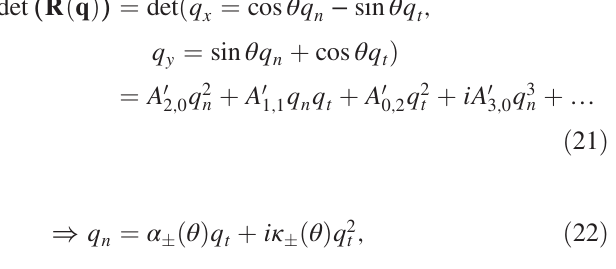
recast the wave vector in terms of the components along this normal direction, q along the tangent direction, ˆ q This method allows us to rewrite the determinant in the new